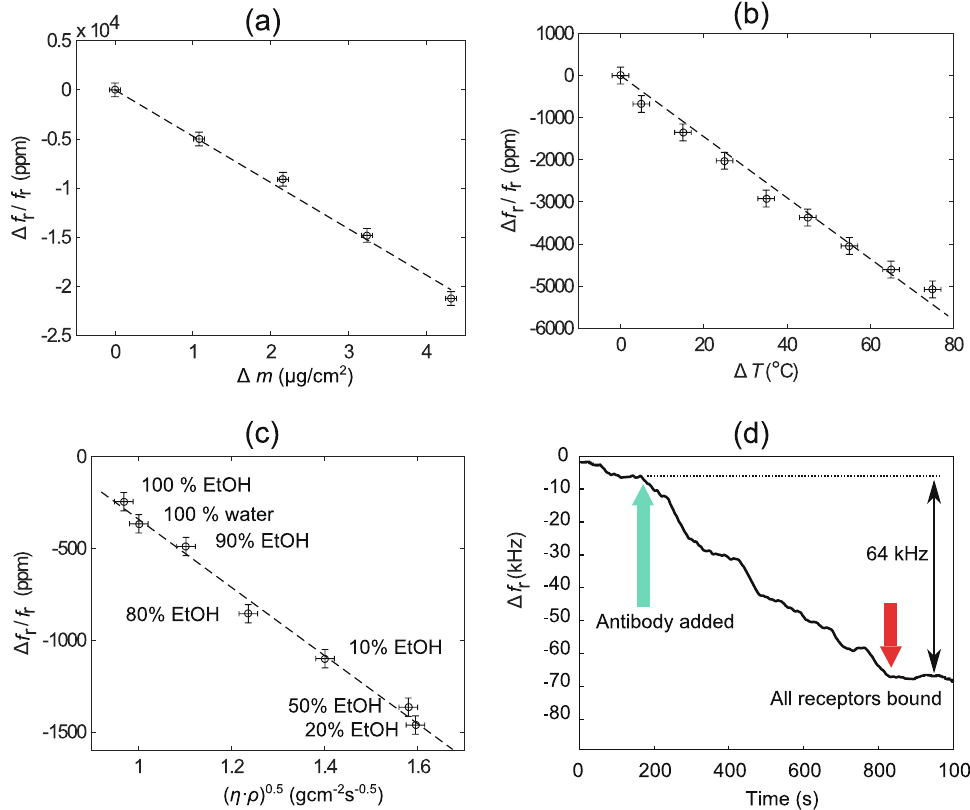
Figure 6. ( a ) Mass sensitivity calibration by the deposition of known thicknesses of Al on the resonator surface area, S m = (4.95 ± 0.08) kHz · cm 2 /ng. ( b ) Temperature effect on shear mode f r , which decreases with temperature with a TCF value of − 66 ppm/K. ( c ) Effect of ethanol-water mixtures with the shear mode f r . ( d ) Detection of biotin conjugated Rabbit IgG in-liquid using the shear resonance of a functionalized device, detection is complete in 600 s. All the data are for the device with Al deposited at T S = 100